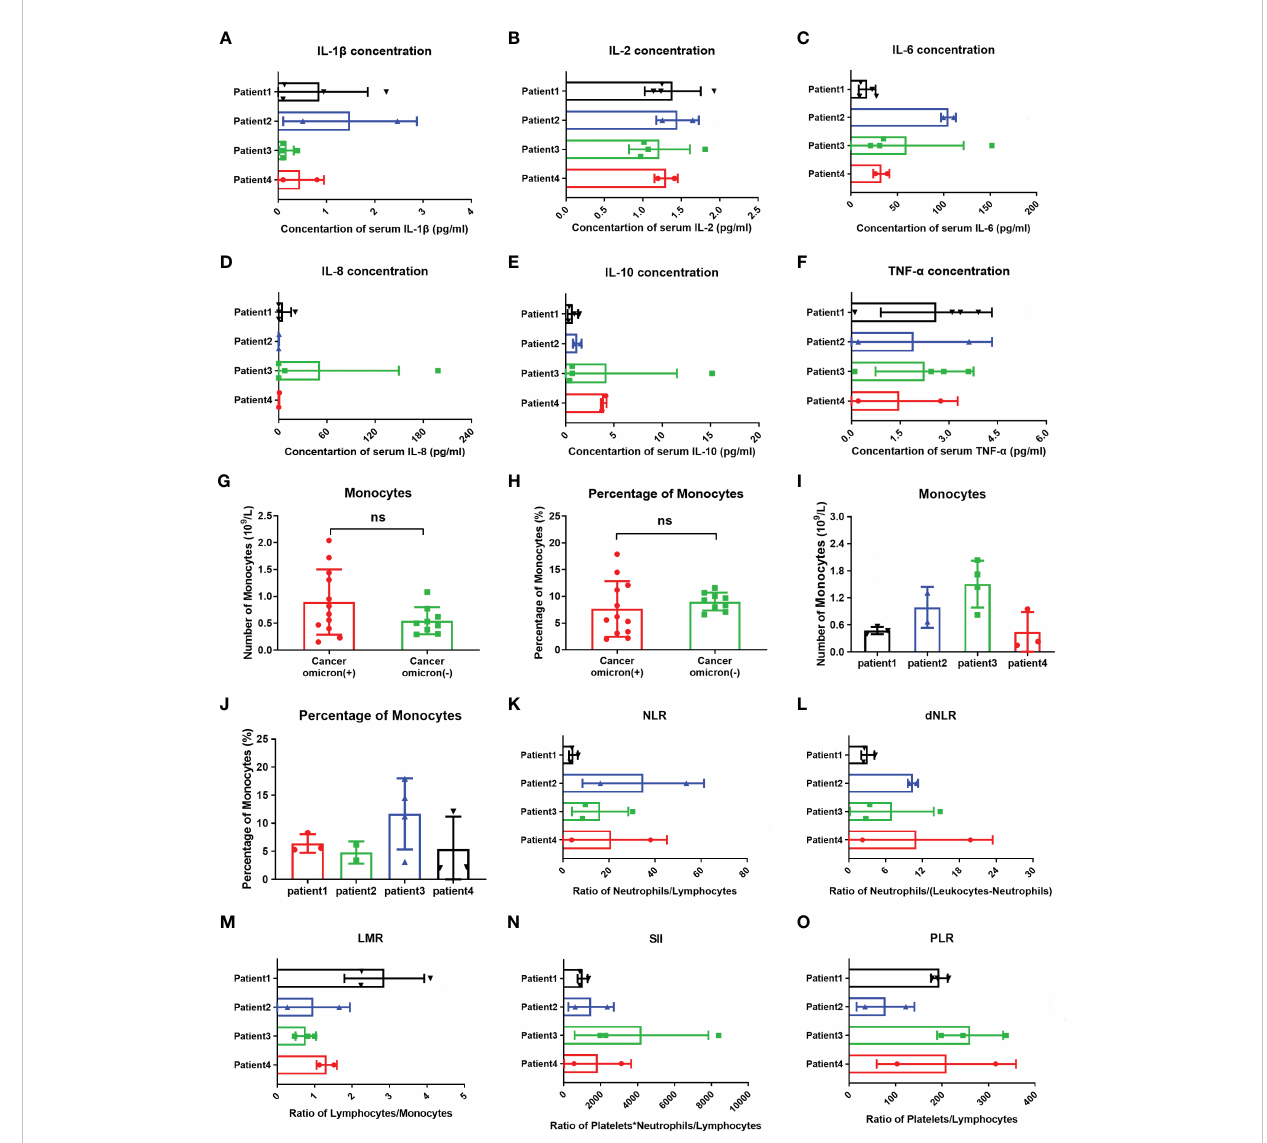
FIGURE 5 Comparisons of cytokines, monocytes, and in fl ammation indexes in four cancer infected patients and monocytes between cancer patients with and without omicron infection. The comparison of overall IL-1 b (A) , IL-2 (B) , IL-6 (C) , IL-8 (D) , IL-10 (E) , TNF- a (F) , count of monocytes (I) , percentage of monocytes (J) , NLR (K) , dNLR (L) , LMR (M) , SII (N) , and PLR (O) between four cancer patients with Omicron virus infection during clinical observation. (G, H) The comparison of monocyte counts and monocyte percentages between cancer patients with and without Omicron infection during clinical observation. Points in each bar represent four subjects ’ data from different time points. ns, not statistically signi fi